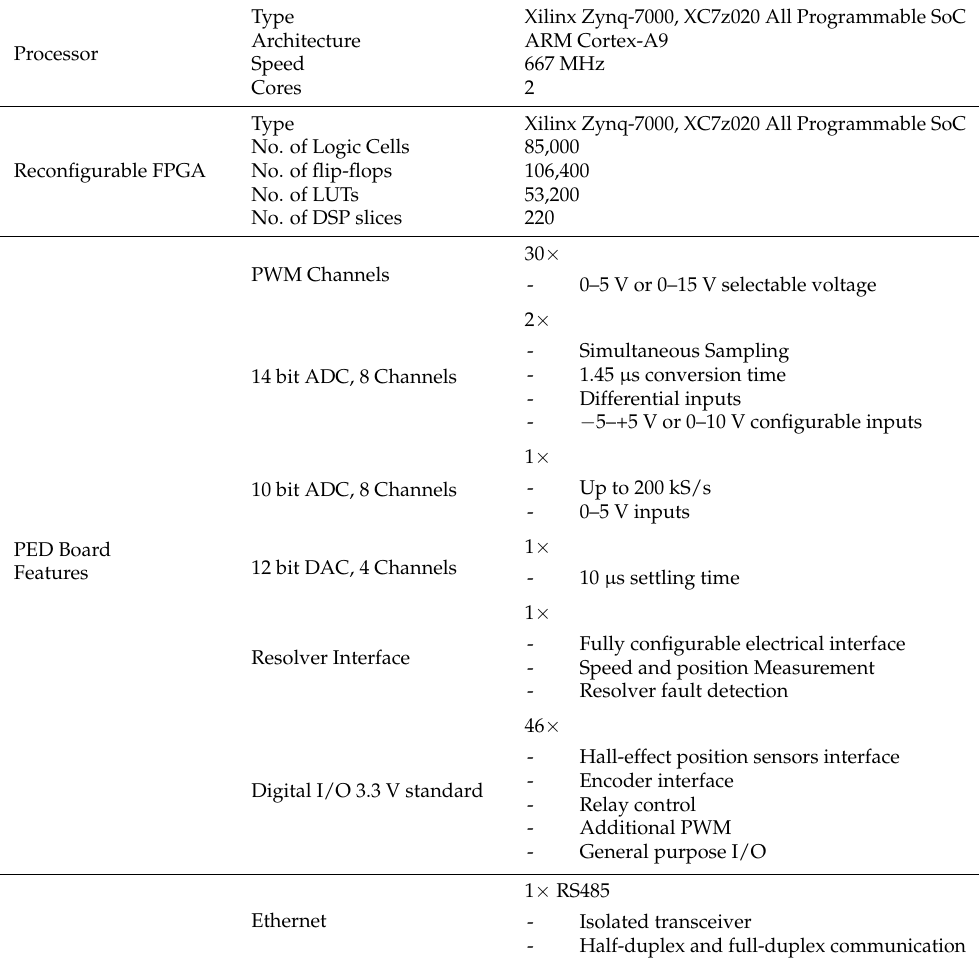
Table 1. The sbRIO Module and PED-board main